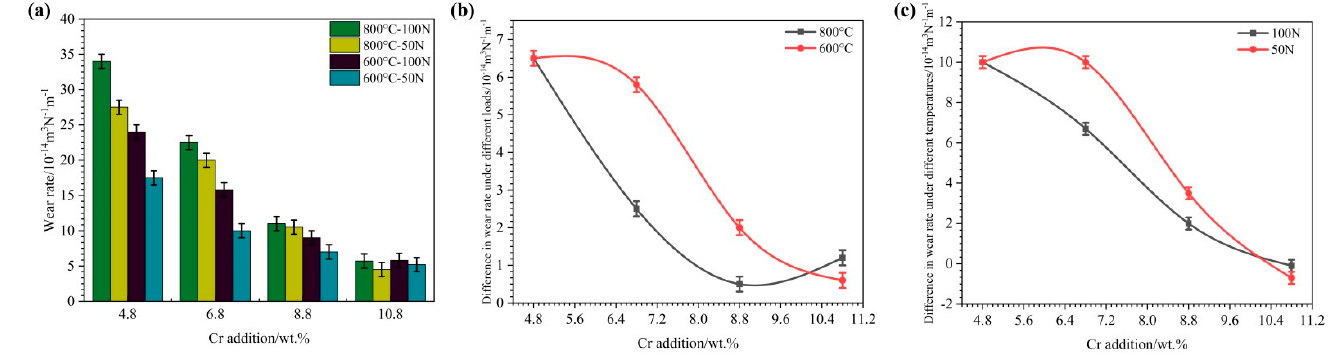
Figure 5. High-temperature oxidation wear rates of HBHSSs with various Cr contents at different testing temperatures and applied loads: ( a ) oxidation wear rates under different loads at 800 °C and 600 °C vs. Cr addition; ( b ) different values of oxidation wear rate at 100 N and 50 N loads vs. Cr addition; ( c ) different values of oxidation wear rate at 600 °C and 800 °C temperatures vs. Cr addition.